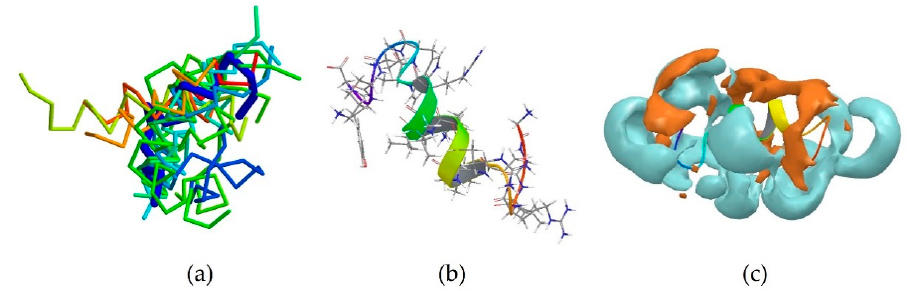
Figure 4. ( a ) Members of cluster 4 are shown superimposed to the centroid 2NDC (thick blue trace). 9 members out of 13 also assume at least a partial α -helical conformation; ( b ) Experimentally-derived conformation of peptide 2NDC; ( c ) PDB entry 2NDC with its surface investigated. Hydrophobic areas are shown in amber, hydrophilic in cyan.